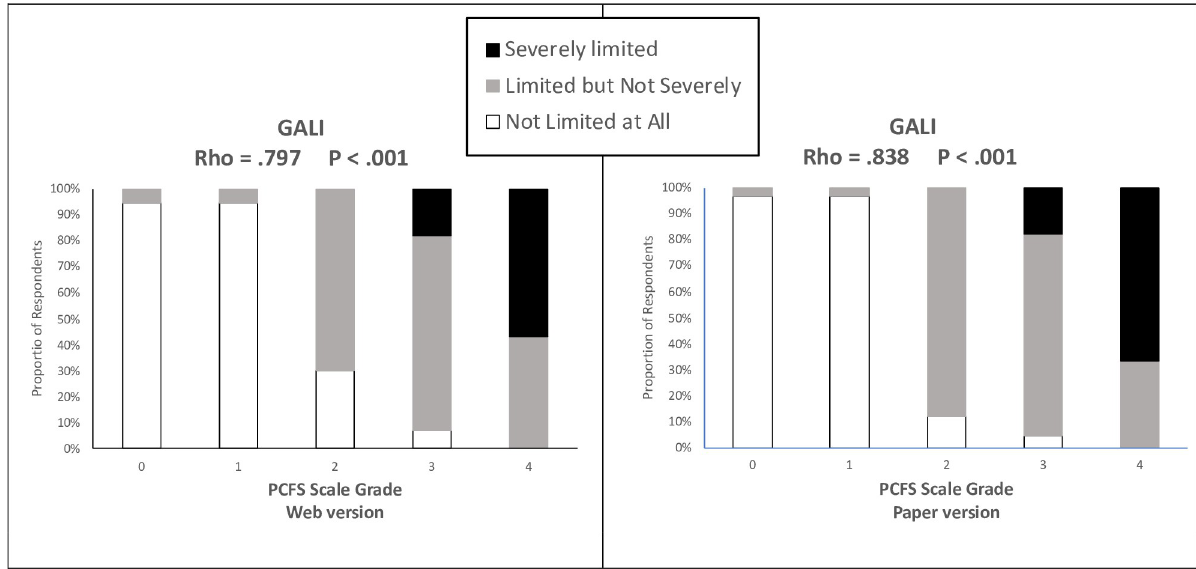
Fig 1. Associations between level of impairment in functional status and different degrees of the Global Activity Limitation Indicator (GALI). Abbreviatures: GALI, Global Activity Limitation Indicator; PCFS, Post-COVID-19 Functional Status.